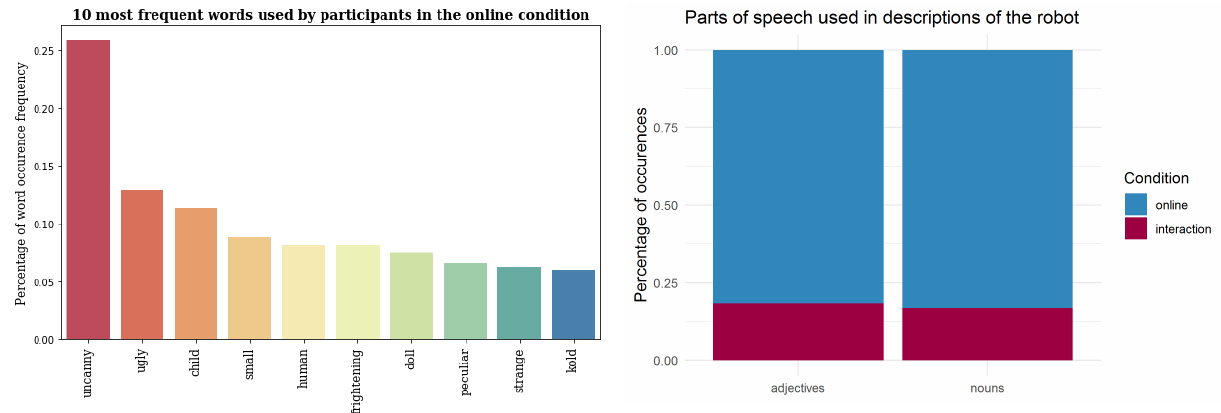
Figure 4: Parts of speech used to describe the robot across two conditions.